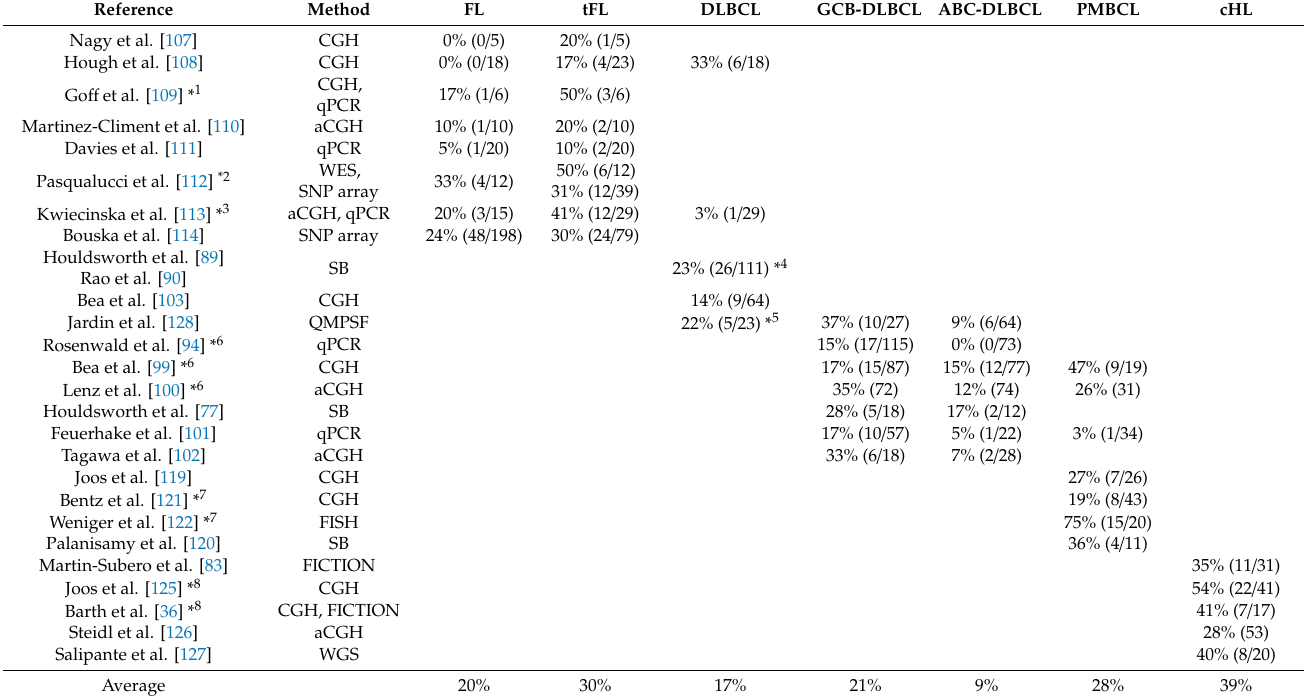
Table 1. Frequency of REL gene locus gains in human B cell lymphoma subtypes. The frequencies of gains including amplifications are displayed. In parenthesis, the fraction of the total number of investigated patients is given. The average percentage of REL gain per subtype (bold, last row) was calculated using the sum of total reported patient numbers. The average for DLBCL includes data from both GCB- and ABC-DLBCL subgroups. The table summarizes the literature with no claim to completeness of published datasets. * 1 Data were confirmed by qPCR. * 2 Numbers for two analyzed patient panels (discovery panel, screening panel) are given. * 3 Numbers refer to aCGH analysis. Part of the patient panel was additionally analyzed by qPCR. * 4 largely redundant cohorts. Numbers displayed as given in Houldsworth et al. [89]. * 5 23 samples of this DLBCL cohort were unclassified. * 6 apparently based to large extent on the same cohort. * 7 Weniger et al. [122] selected five samples with and 15 samples without gain / amplification from the Bentz at al. [121] cohort. * 8 Barth et al. [36] studied samples from the Joos et al. [125] cohort. Cases consistently gained in both CGH and FICTION analysis were considered positive. Method abbreviations: aCGH, array comparative genomic hybridization; CGH, comparative genomic hybridization; FICTION, FISH and combined immunophenotyping and interphase cytogenetics; FISH, Fluorescence in situ hybridization; QMPSF, quantitative multiplex PCR of short fragments; qPCR, quantitative polymerase chain reaction; SB, Southern Blot; SNP array, single nucleotide